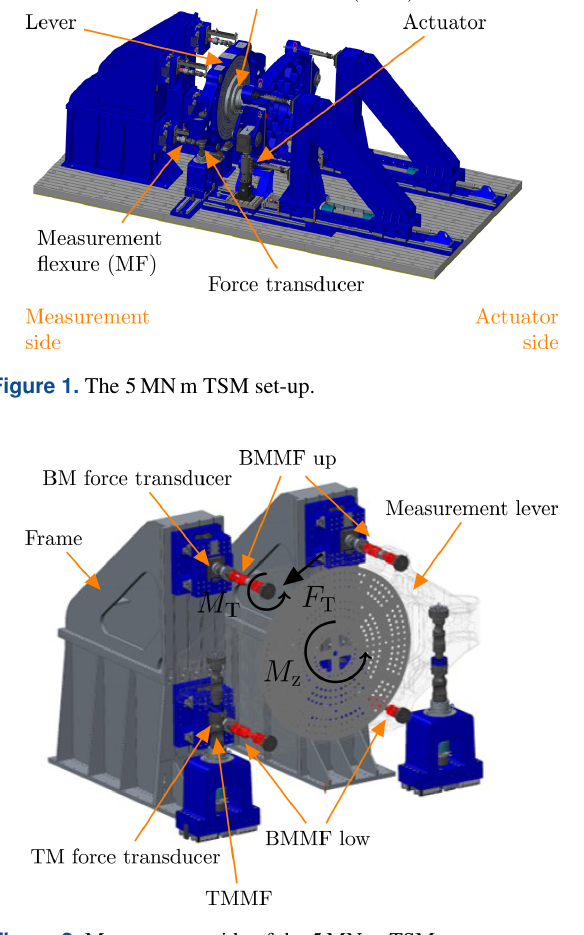
Figure 2. Measurement side of the 5MNm TSM.